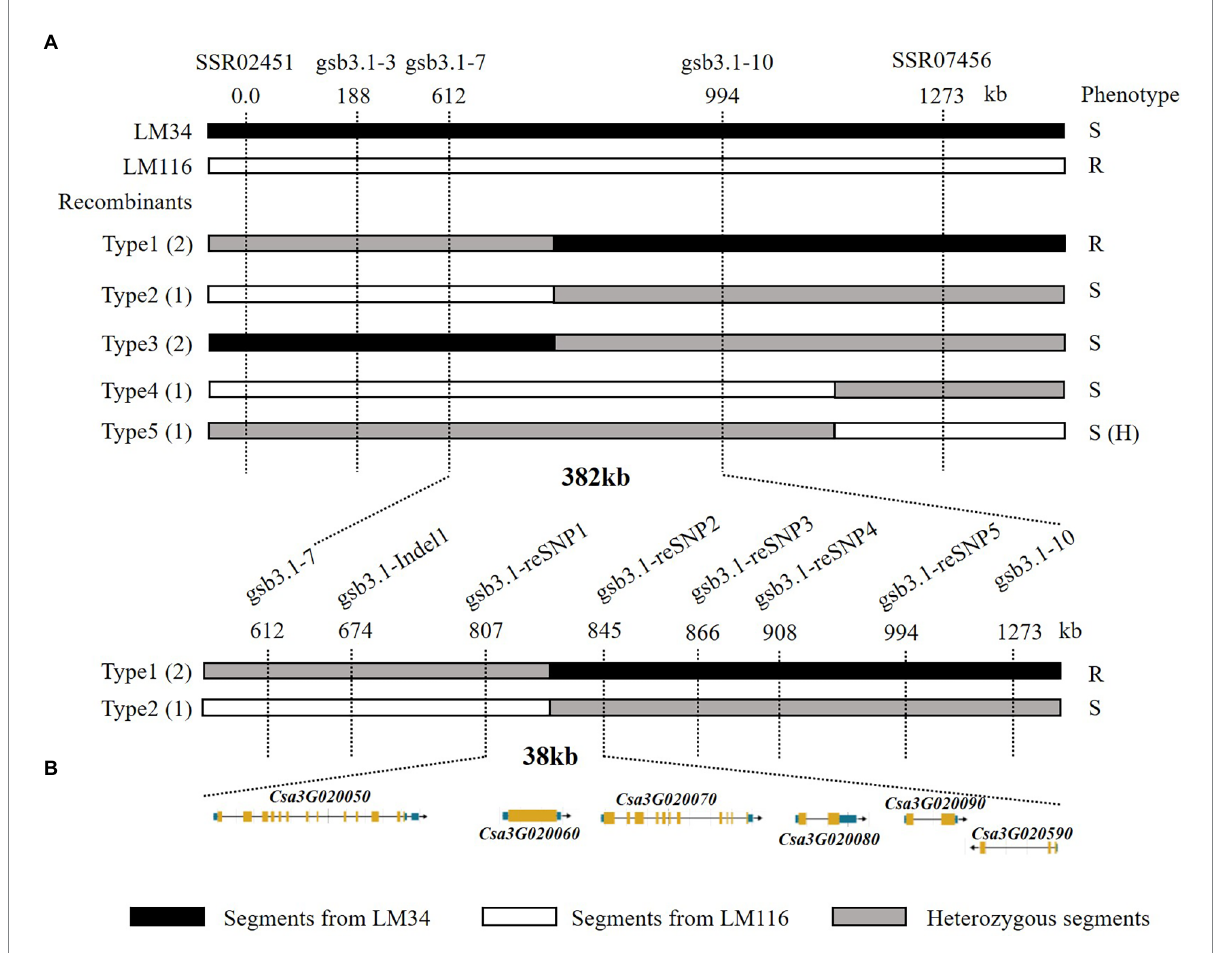
FIGURE 4 Fine mapping of the gsb3.1 QTL in cucumber. (A) Genetic mapping of gsb3.1 , using key recombinants from the F 2 segregated population, i.e., “LM34” and “LM116.” The 38 kb region of gsb3.1 was narrowed in two phases of fine-mapping. The numbers below the markers indicate the physical position of markers. (B) Six annotated genes located in the 38 kb region according to the cucumber “9930”_v2 reference genome. R, resistant; S, susceptible; S (H), susceptible (dominant heterozygous).